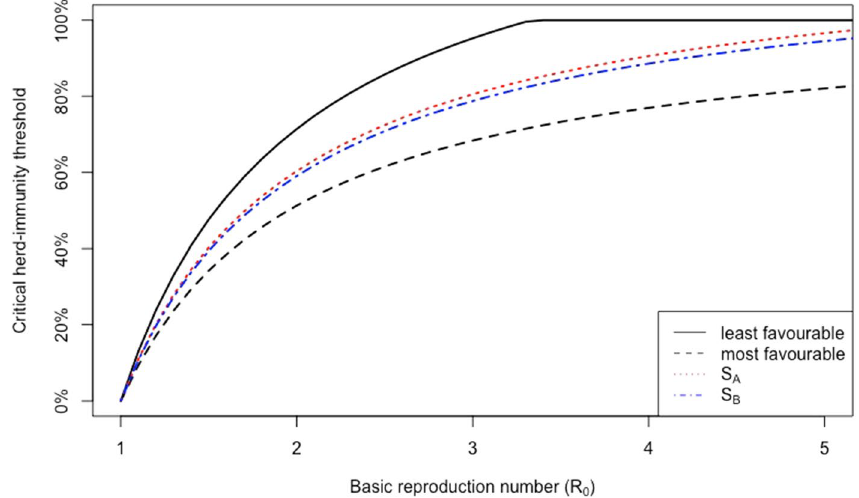
Figure 1. Illustration of the herd-immunity thresholds for four different vaccine-allocation strategies as a function of R 0 when k = 6 vaccines are available and effectivenesses belong to the interval (0.7, 0.975): the black dashed curve represents the most favourable strategy, and the black solid curve is the least favourable strategy; all vaccine-allocation strategies will be between these two curves; the red dotted curve and the blue dashed-dotted curve are two different examples of vaccines strategies, represented by S A and S B , respectively. The strategy S A is equivalent to a single-vaccination strategy whose effectiveness is the average of effectivenesses. We can also propose strategies like S B that are closer to the most favourable